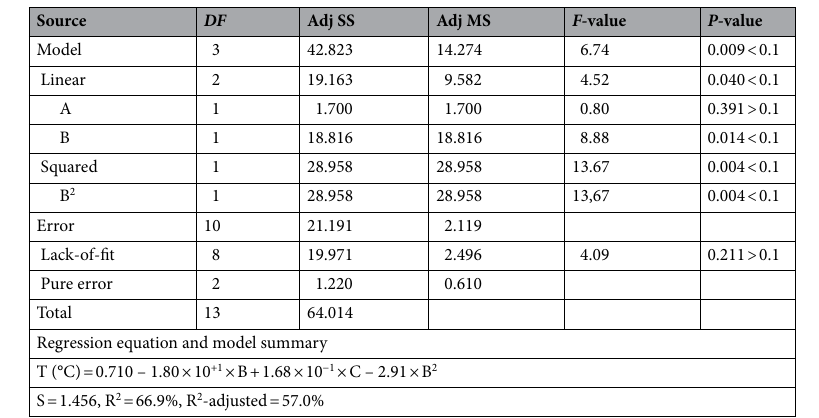
Table 1. The analysis of variance (ANOVA) table for the response surface model developed to describe the effect of operating parameters of pulse-modulated radio-frequency atmospheric pressure glow discharge (pm-rf-APGD), i.e. A-DOX concentration in the flowing liquid electrode (FLE) solution (in µg mL −1 ), B-FLE solution flow rate (in mL min −1 ), and C-duty cycle for the pulse modulated radio-frequency alternating current, on temperature (T) of DOX-containing solutions treated by pm-rf-APGD. DF: Degrees of freedom. Adj SS: adjusted sums of squares. Adj MS: adjusted mean squares. F -value: the value of the Fisher–Snedecor test. P -value: probability